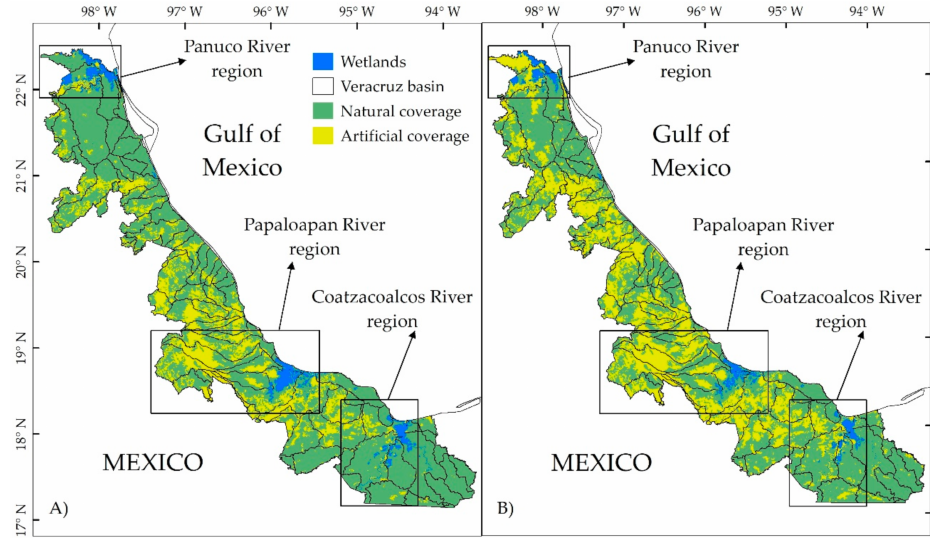
Figure 5. Spatial distribution of natural vegetation and induced land use in Veracruz. ( A ) 1976 and ( B ) 2016. Squares correspond to the location of the regions and wetlands under